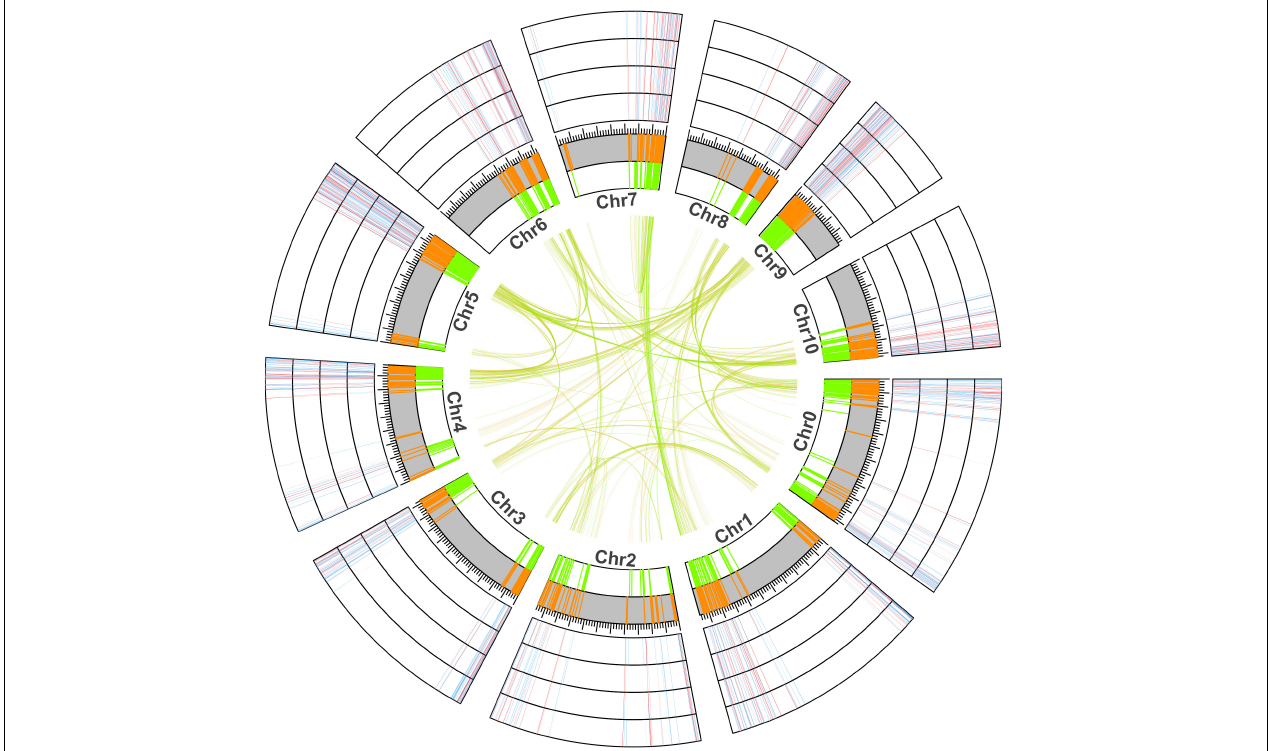
FIGURE 2 | The location and expression analyses of young and old duplicate genes in Vernicia fordii . The green and orange represent the positional information of old and young duplicate genes on chromosomes in V. fordii , respectively. Blue and red represent the low and high expression levels of duplicate genes under Fusarium wilt disease, respectively. The outermost ring indicates F3, followed by F2, F1, and F0.